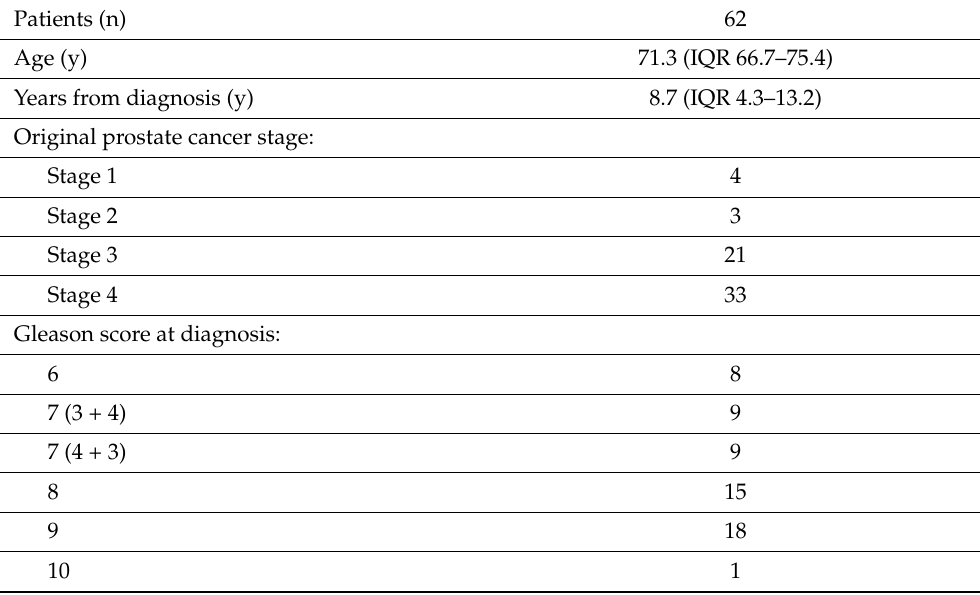
Table 1. Patient characteristics. Gleason score information was missing from two patients since a biopsy was not done due to a large degree of metastasis and clinically obvious T4N1M0 and T4N1M1 disease. T-stage information was missing from one